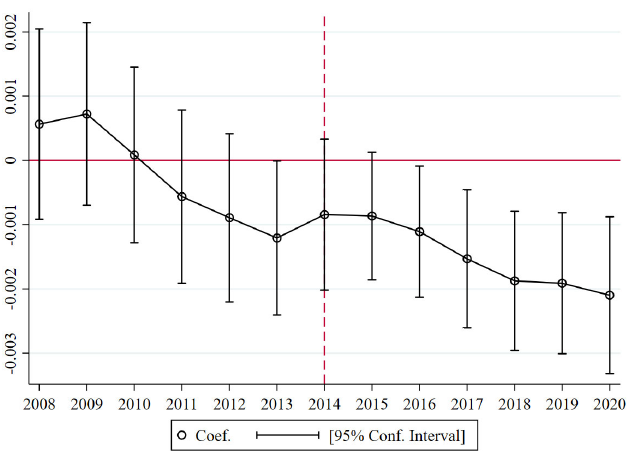
Figure 2. Parallel trend test chart.